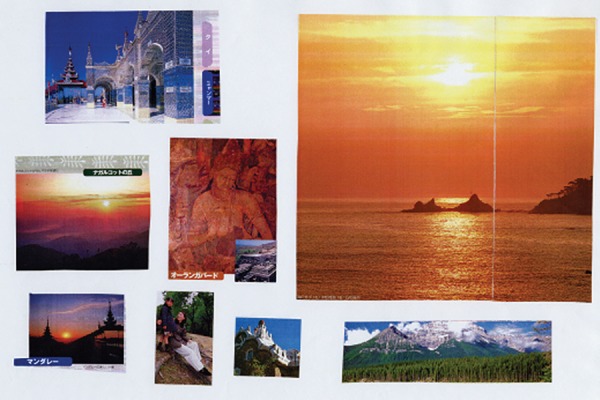
Spiritual image.